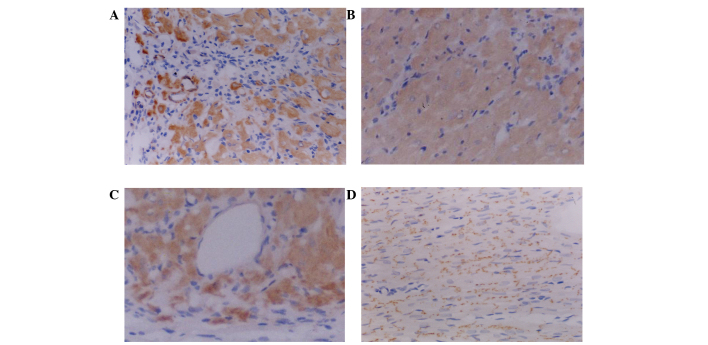
Immunohistochemical staining of connexin 43 expression in myocardial infarction area of New Zealand rabbit myocardium in vitro following transplantation of BMSCs from groups (A) A1, transfected with Nkx2.5 and co-cultured with myocardial cells (magnification, ×200); (B) A2, blank BMSCs (magnification, ×200); and (C) B1, transfected with GATA-4 and co-cultured with myocardial cells (magnification, ×400). (D) Immunohistochemical staining of connexin 43 in the B2 group, blank BMSCs (magnification, ×100). BMSCs, bone marrow mesenchymal stem cells.